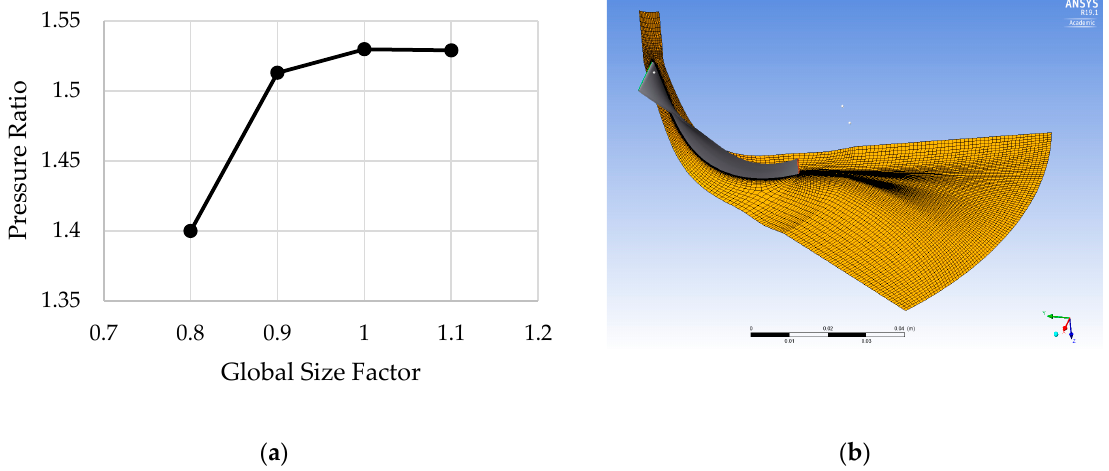
Figure 4. Mesh Convergence of Impeller Geometry ( a ) and Meshed Impeller Blade with Global Size Factor of 1 ( b ).